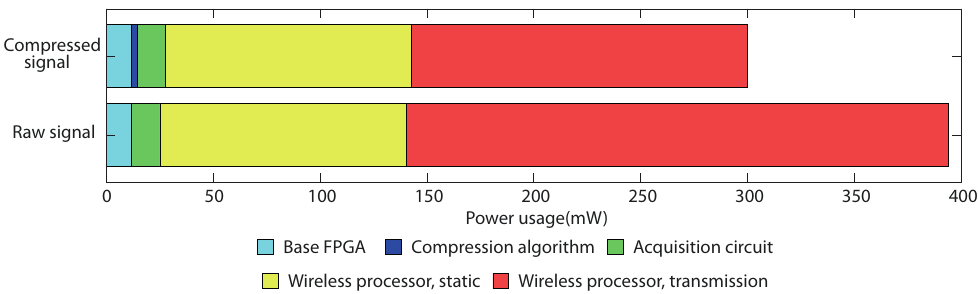
Figure 8. Power usage of the sample hardware implementation transmitting the compressed signal and the raw, uncompressed signal.